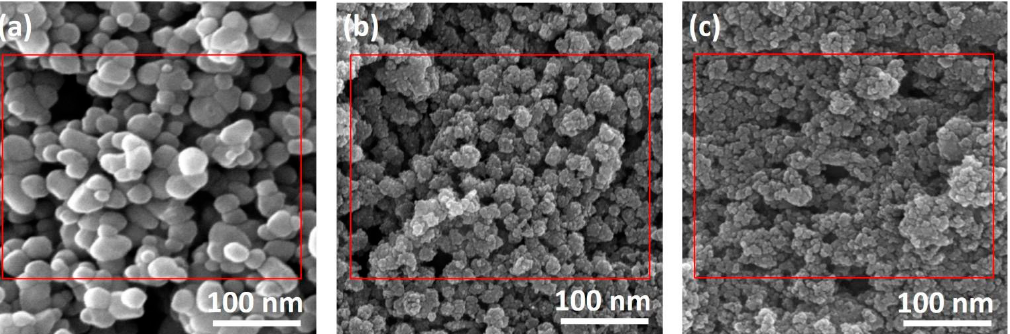
Figure 3. SEM image of titanium nanoparticles formed by: ( a ) Bacillus subtilis , ( b ) Cassia fistula and ( c ) hydrothermal heating showing phase forms.